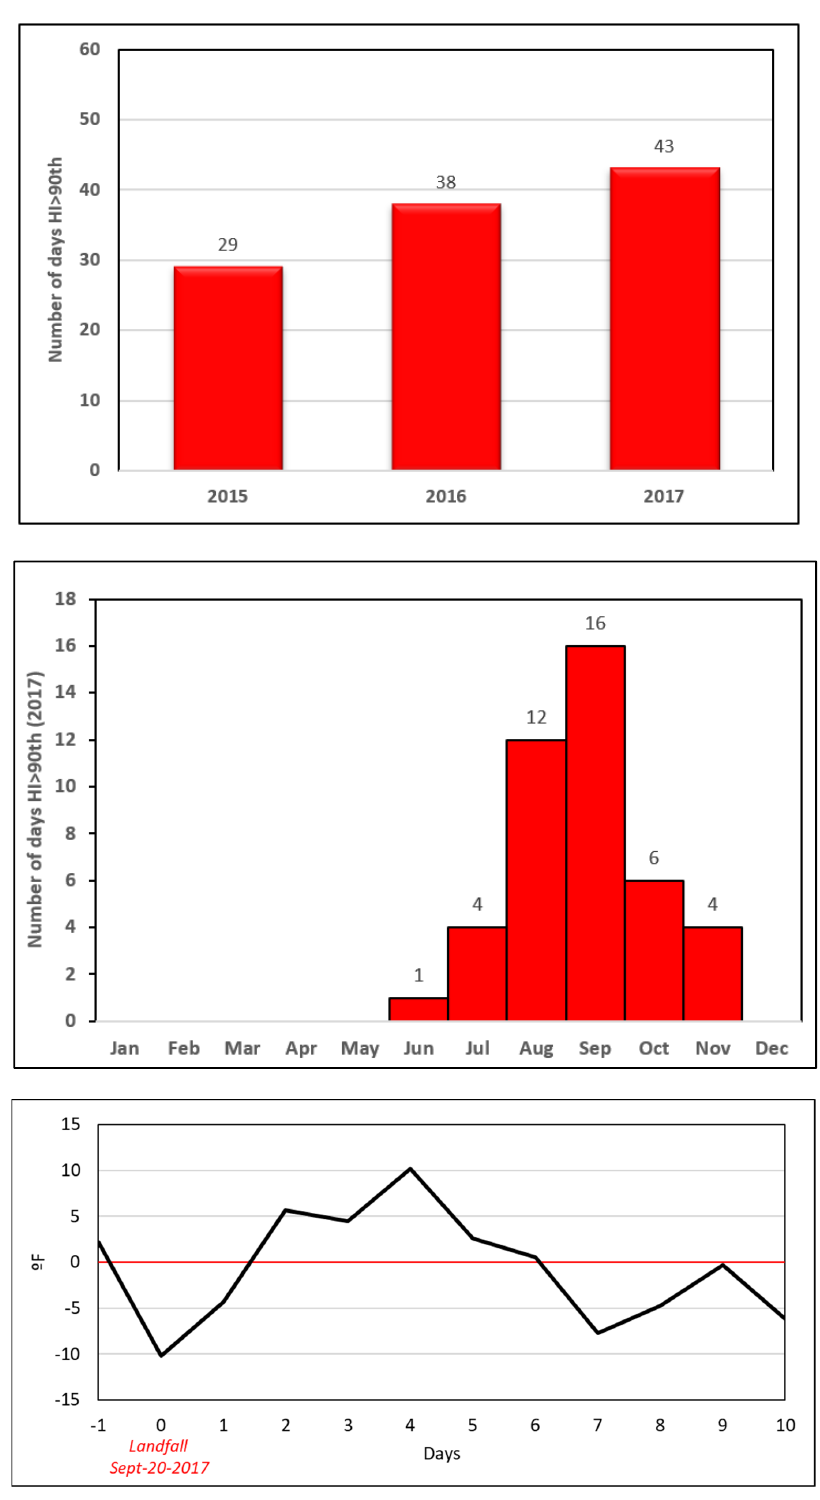
Figure 4. Upper panel: Number of days with heat index > 90th percentile (38 °C) per recent years. Middle panel: number of days with heat index > 90th percentile (38 °C) per months in 2017. Lower panel: days with heat index “above normal” after landfall. The climate data used in this study are derived from the Daymet version 2 dataset, a 1-km gridded product that provides daily values of precipitation and minimum and maximum temperature interpolated and extrapolated from the Global Historical Climatology daily surface observations